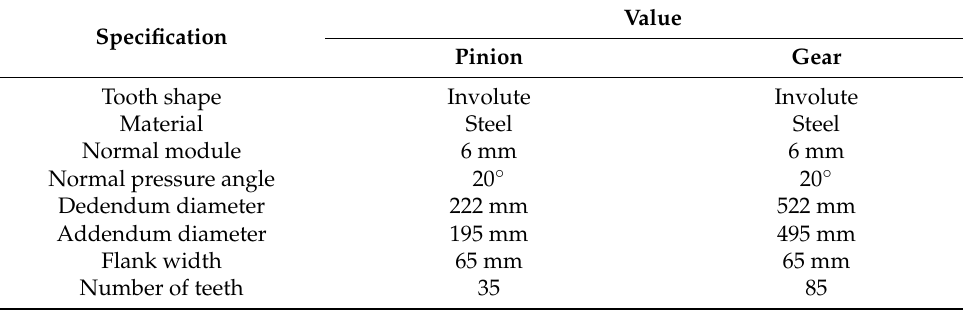
Table 2. Main design parameters of the gear